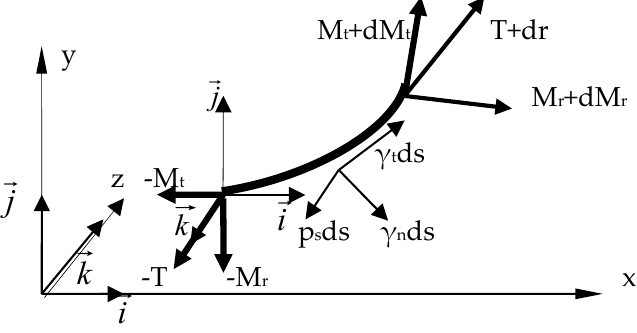
Figure 4. An element of spring between the abscissas s and s + ds .